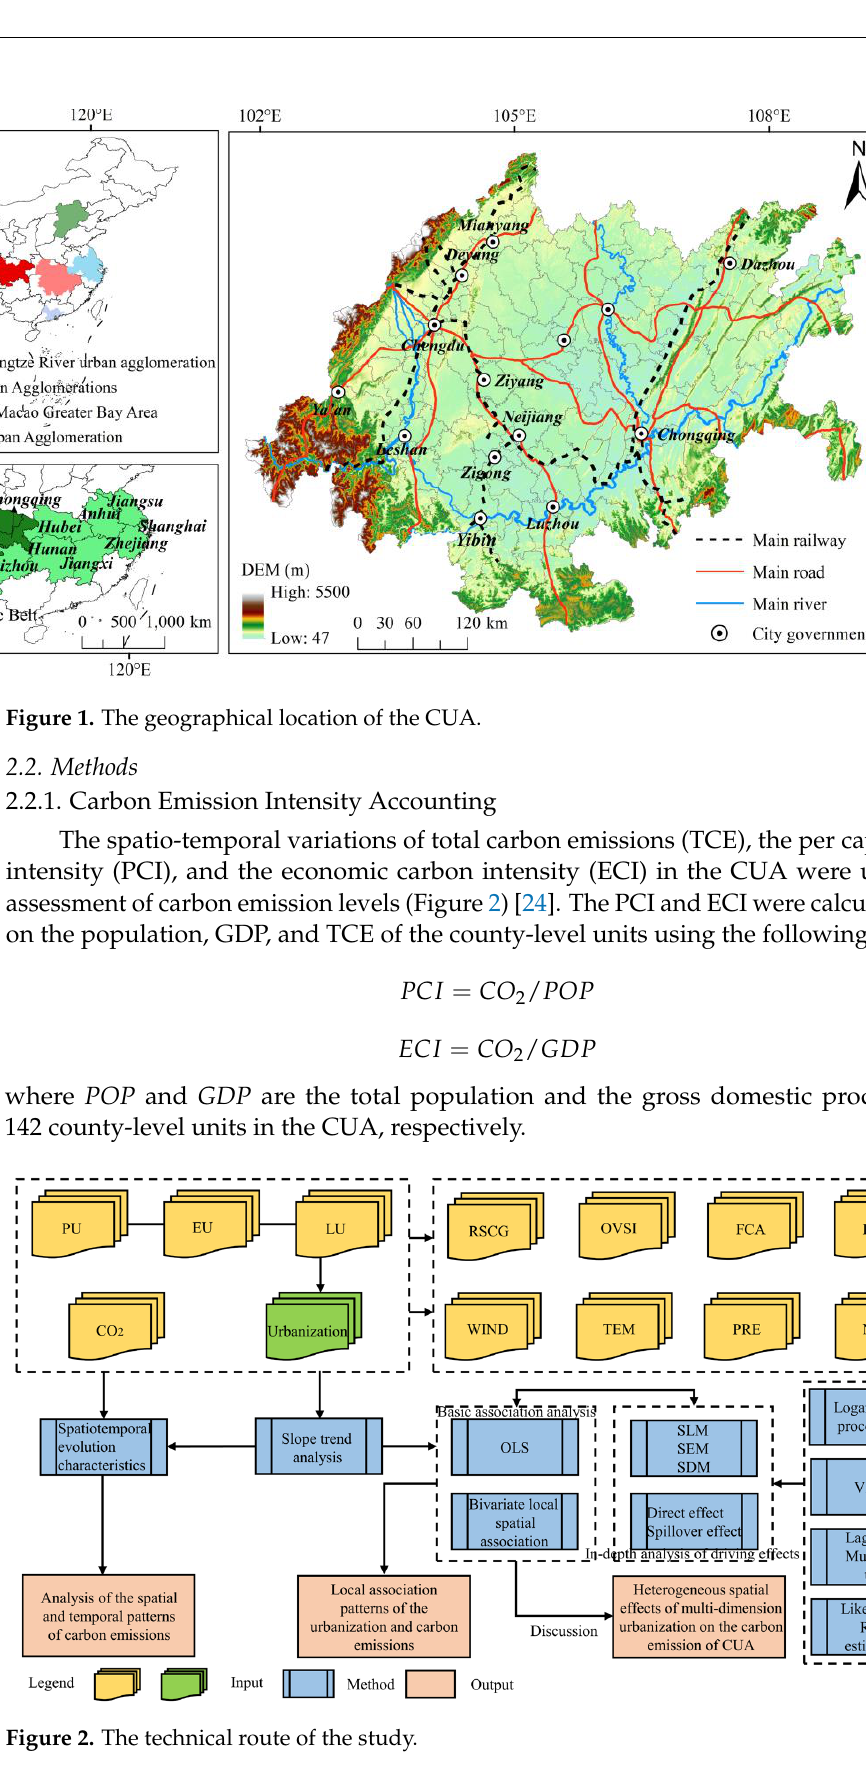
Figure 2. The technical route of the study.